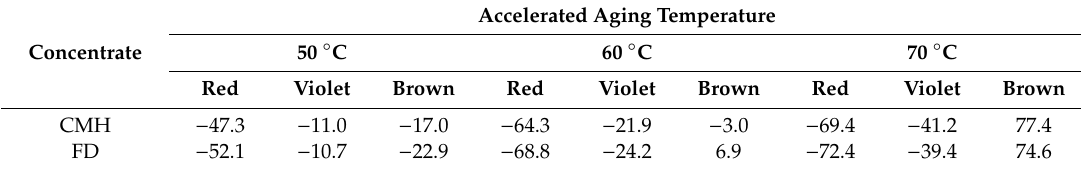
Table 1. Percentage change in red, violet, and brown color of concentrate derived from commercial must heating (CMH) vs. flash d é tente (FD) after nine days of accelerated aging (at 50, 60, and 70 ◦ C). Accelerated Aging Temperature 50 ◦ C 60 ◦ C 70 ◦ C Concentrate Red Violet Brown Red Violet Brown Red Violet Brown CMH − 47.3 − 11.0 − 17.0 − 64.3 − 21.9 − 3.0 − 69.4 − 41.2 77.4 FD − 52.1 − 10.7 − 22.9 − 68.8 − 24.2 6.9 − 72.4 − 39.4 74.6 Values are means from two